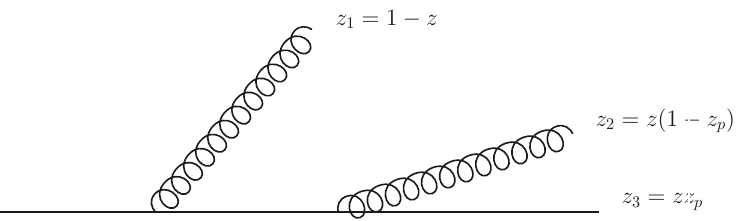
Figure 3. Diagram showing the parametrisation of the energy fraction variables used along with our labelling of the partons in the C 2 F